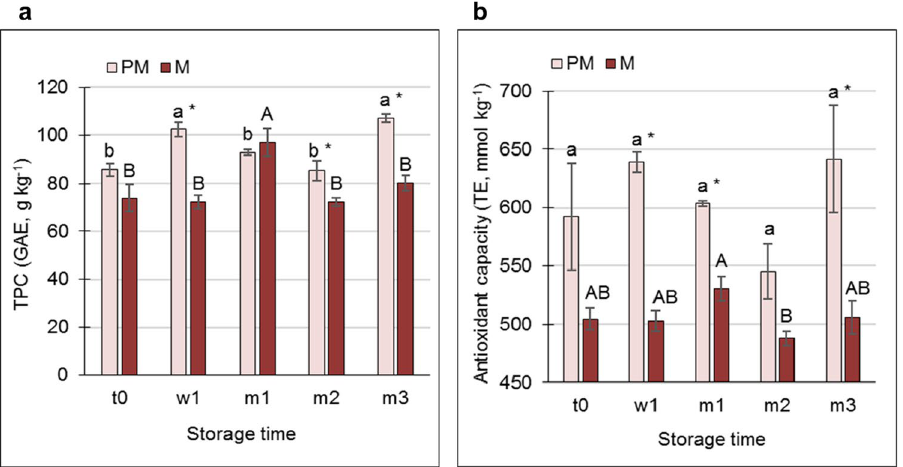
Figure 3. Total polyphenol content (TPC) ( a ) and antioxidant capacity ( b ) in the skin of premature (PM) and mature (M) fruit at harvest (t0), after 1 week in storage (w1), and after 1, 2 and 3 months in storage (m1, m2, m3, respectively). TPC was determined using Folin–Ciocalteu reagent, and is given as gallic acid equivalents (GAE). Antioxidant capacity was determined using the FRAP method, and is given as Trolox equivalents (TE). Values are averages of three biological replicates ± SE. Statistical analysis was performed by Student’s t -test ( P < 0.05). Significant difference among means between time points is indicated by different lowercase letters for PM samples, and uppercase letters for M samples. Asterisks indicate significant differences between PM and M values for the same time